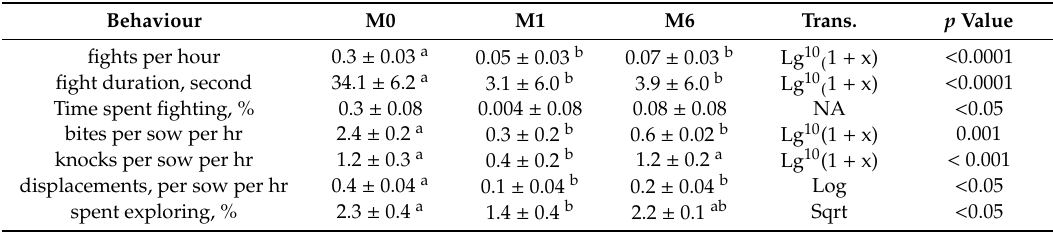
Table 3. The e ff ect of days after mixing on behavioural measures in group housed sows mixed at di ff erent times 1